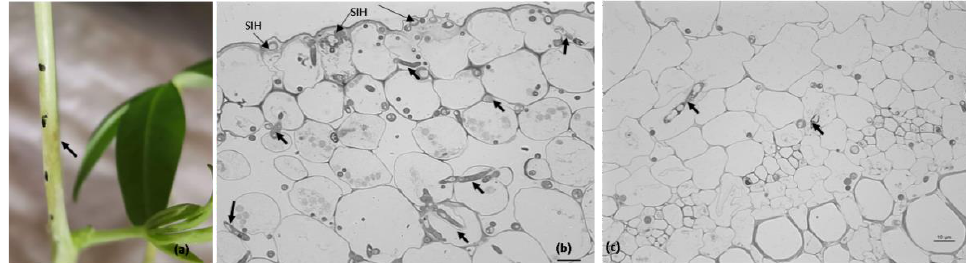
Figure 2. Macroscopic symptoms and the corresponding stage of the Colletotrichum lupini infection process on petioles of Lupinus mutabilis 3 days after inoculation. ( a ). Beginning of disease symptoms (arrow). ( b , c ). Light microscopic observations, toluidine blue staining. ( b ). Infection sites showing subcuticular intramural hyphae (SIH) and hyphae developing intra- and intercellularly (arrows) in epidermal and cortex host cells. Note the degradation of some epidermal cell walls. ( c ). Intra- and intercellular fungal growth (arrows) in cortex cells and vascular cells. Scale bar = 10 µm.